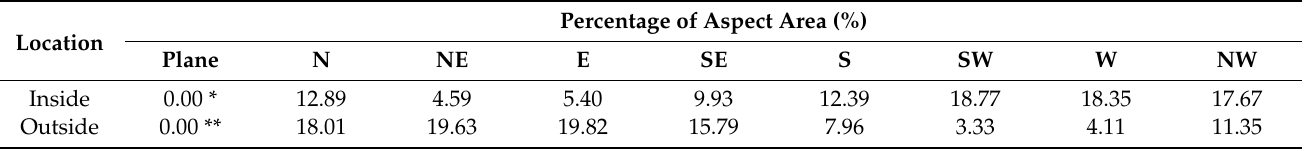
Table 8. Statistical results of the proportions of the inside and outside aspect areas of the pit rim structure.